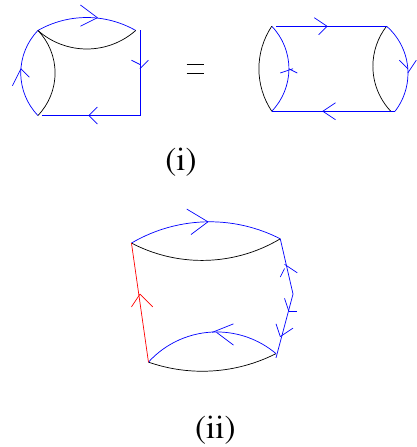
Figure 12 . ( i ) the equal graphs, and ( ii ) the auxiliary